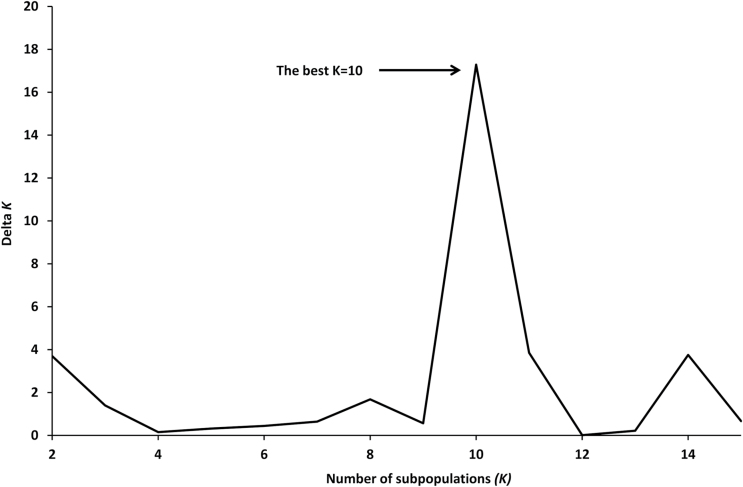
Determination of the true number of groups based on the second order rate of change of the likelihood (ΔK, see the calculation methods; Evanno et al., 2005) using DArT marker data. The true K(10) is shown as the uppermost level of structure.